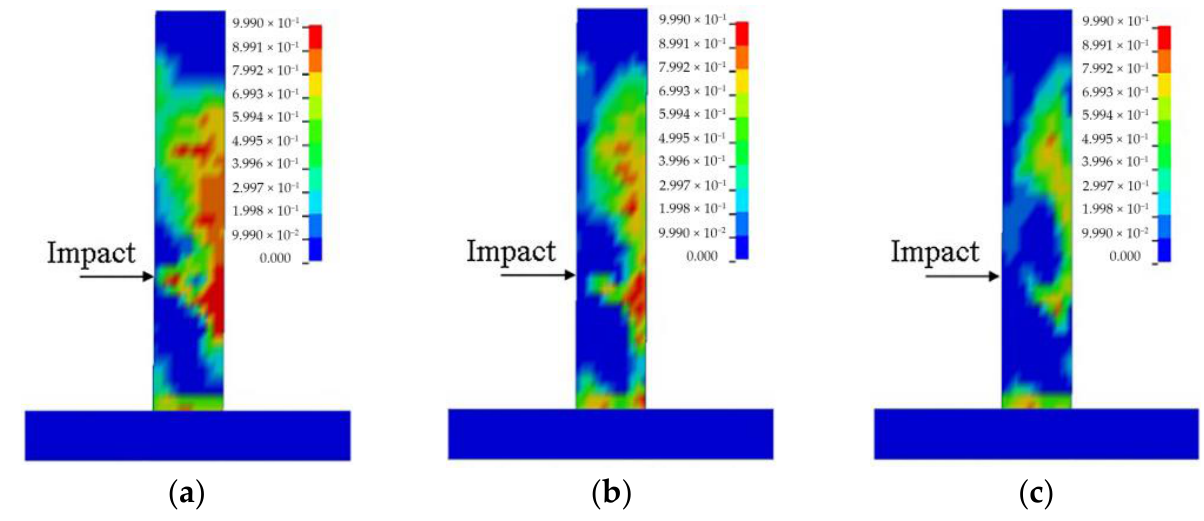
Figure 19. Comparison of impact damage to columns with different longitudinal reinforcement ratios: ( a ) Φ 6 longitudinal rebar; ( b ) Φ 12 longitudinal rebar; ( c ) Φ 18 longitudinal rebar.